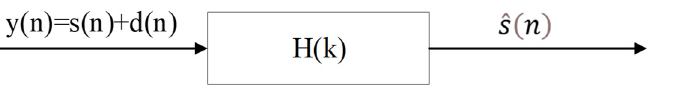
Figure 3. The input–output relationship of Wiener filtering. 𝑦(𝑛) : the input signal, 𝑠(𝑛) : the pure signal, 𝑑(𝑛) : noises, 𝐻(𝑘) : the wiener filtering spectrum estimator, 𝑠̂(𝑛) : the output signal.